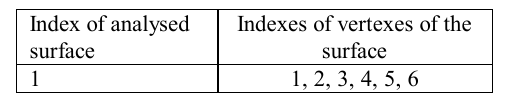
Table 1. Map of indexes of the analysed surfaces and indexes of the vertexes of the surface for Scenario 1.